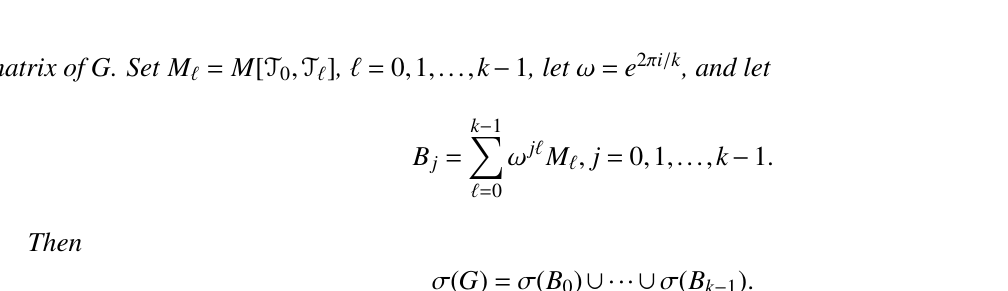
matrix of G. Set M (cid:96) = M [ T